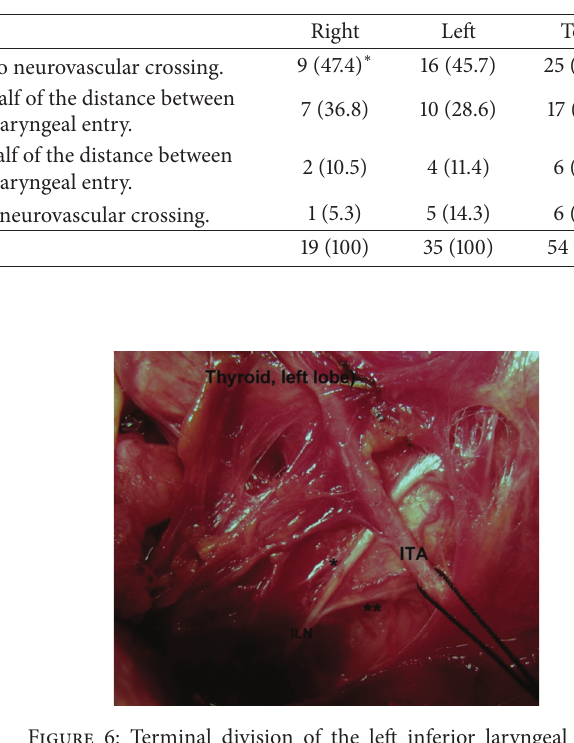
Table 3: The incidence of terminal division of the ILN according to anatomical classification.